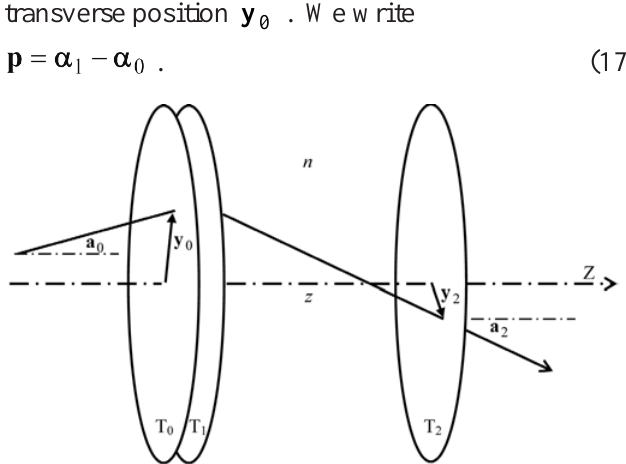
Figure 3 A pencil of rays, only one of which is shown, travers- ing an optical system consisting of a thin system followed by a homogeneous gap of width z . The thin system lies between transverse planes T immediately before and T